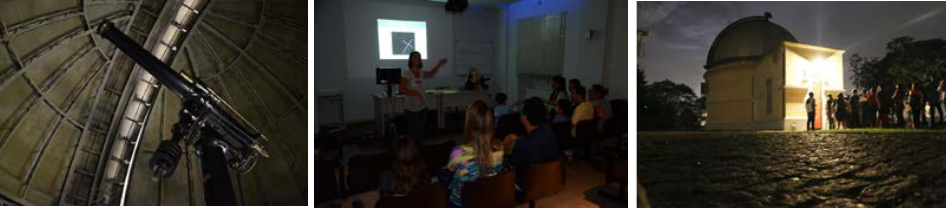
Fig. 1. Left: 21-cm centenary refractor (Luneta-21); Middle: “The Skyof the Month” talk presented at the auditorium; Right: Public lining up to observe with